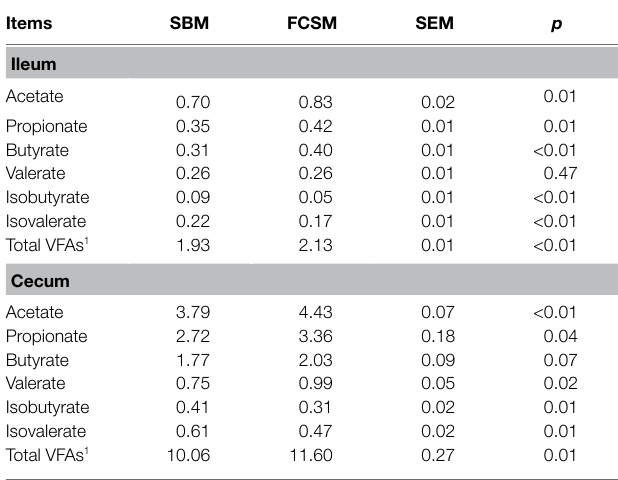
TABLE 8 | Effects of protein source on volatile fatty acids composition in ileal and cecal digesta of weaned pigs (mg/g digesta). Items